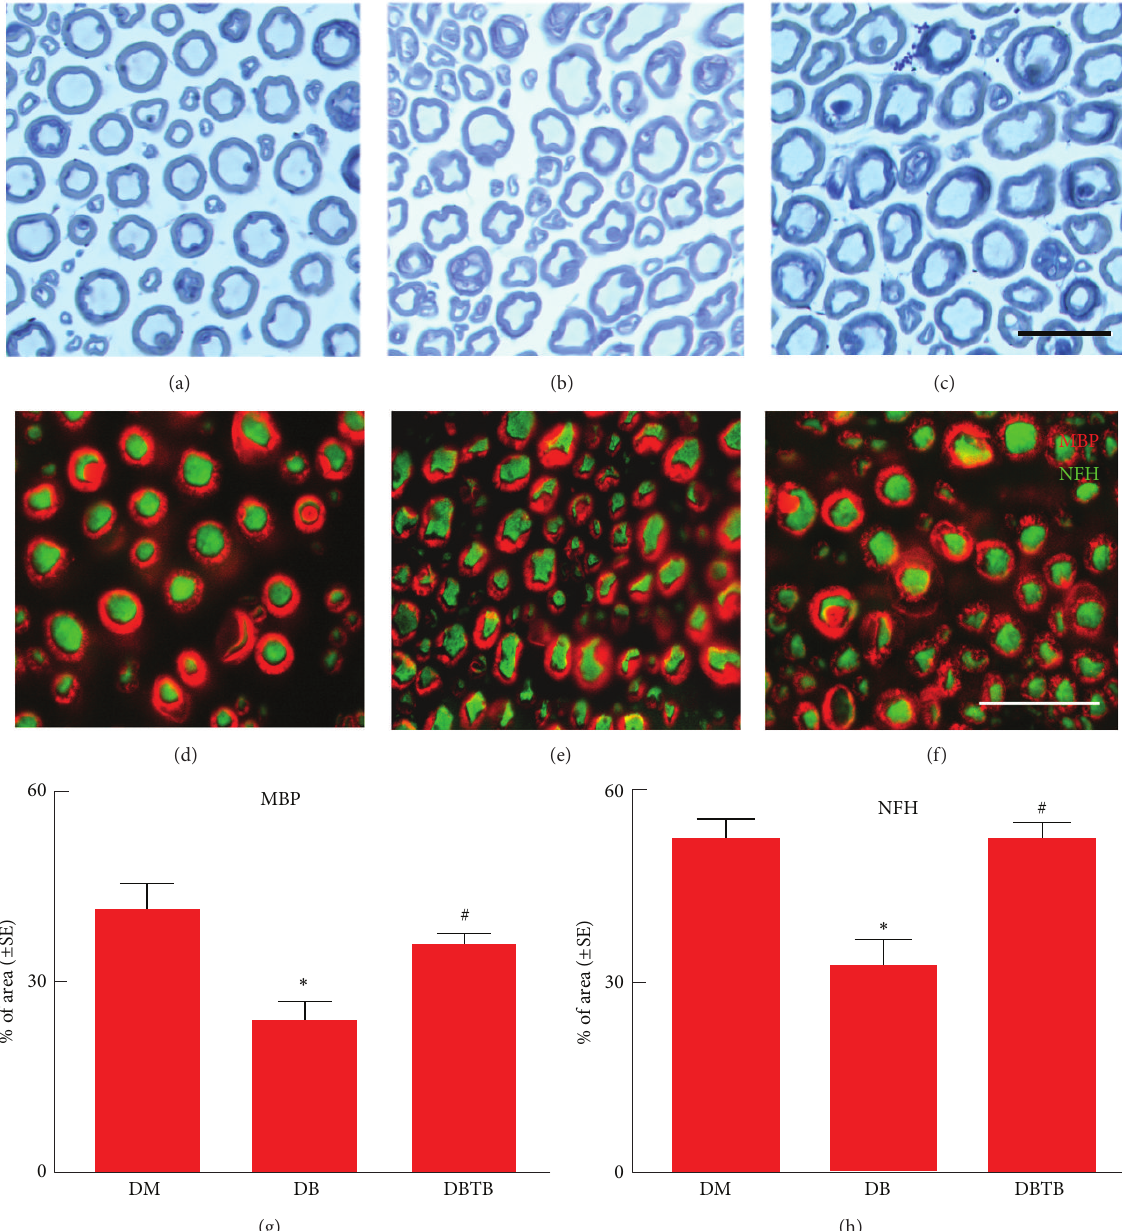
Figure 3: Effect of T 𝛽 4 on MBP, NF-H, and morphometric change of myelinated sciatic nerves. Panels (a) to (c) show semithin toluidine blue-stained cross sections of sciatic nerves from a representative nondiabetic mouse (a), diabetic mouse treated with saline (b), and diabetic mouse treated with T 𝛽 4 (c) for 16 weeks. Panels (d) to (f) are double immunofluorescent images showing MBP and NF-H immunoreactive sciatic nerves of a representative nondiabetic mouse (d), diabetic mouse treated with saline (e), and diabetic mouse treated with T 𝛽 4 (f) for 16 weeks. Panels (g) and (h) show quantitative data of the percentage of MBP (g) and NF-H (h) immunoreactive area. Bars in 𝐶 = 50 𝜇 m and 𝐹 = 25 𝜇 m. ∗ 𝑃 < 0.05 versus the nondiabetic group (DM) and # 𝑃 < 0.05 versus diabetic mice treated with saline (DB). 𝑛 = 10 /group.